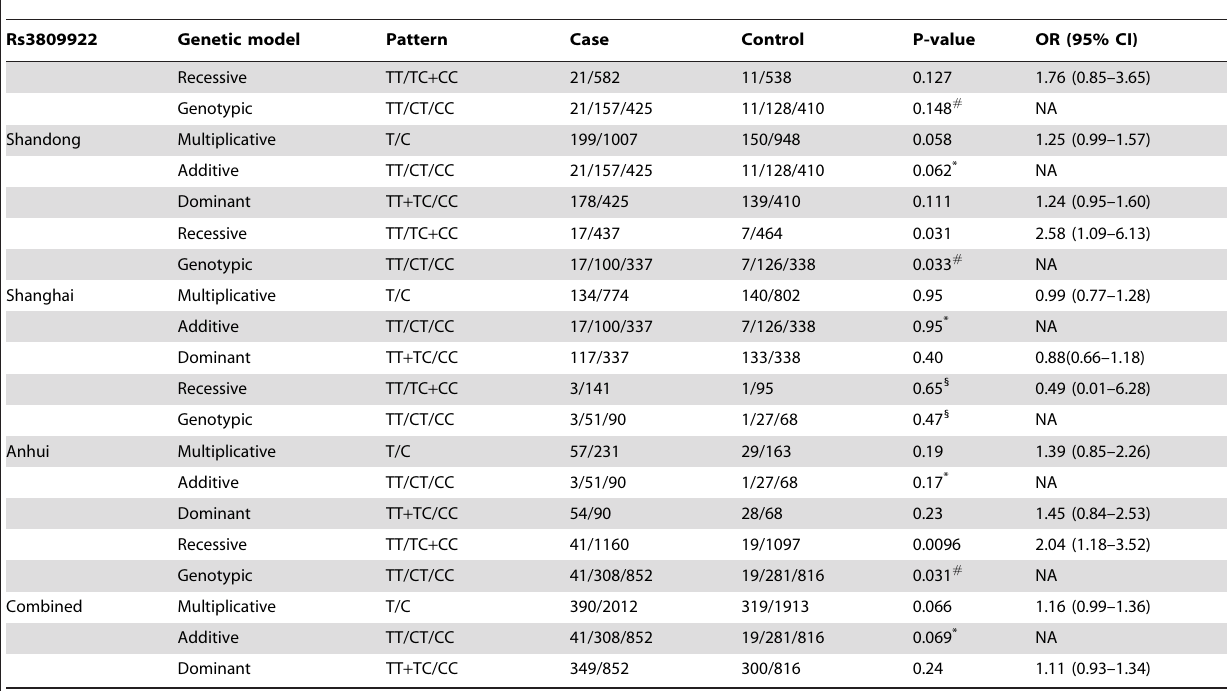
Table 2. Association of SMAD7 rs3809922 variant with CHD in 3 independent case-control